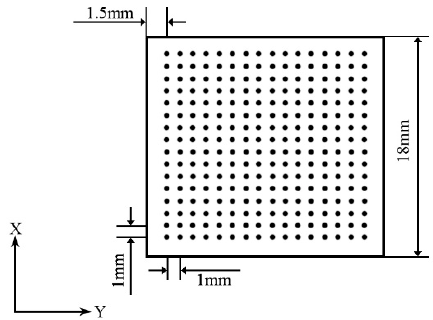
Figure 2. Schematic illustration showing the position of hardness measurement.